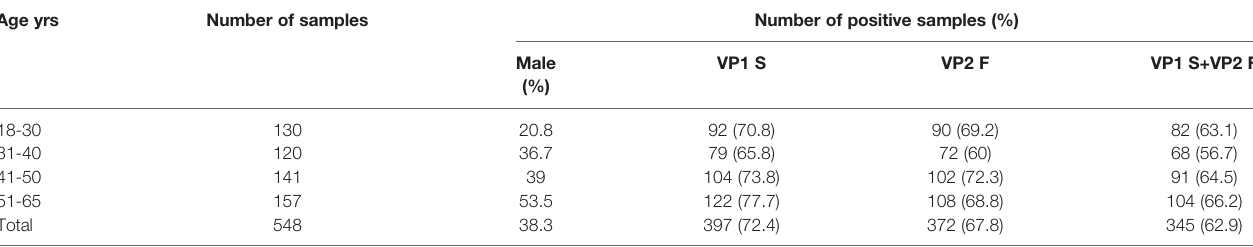
TABLE 3 | IgG antibodies seroprevalence against MCPyV VP1 S and VP2 F peptides in heathy subjects (HS). Age yrs Number of